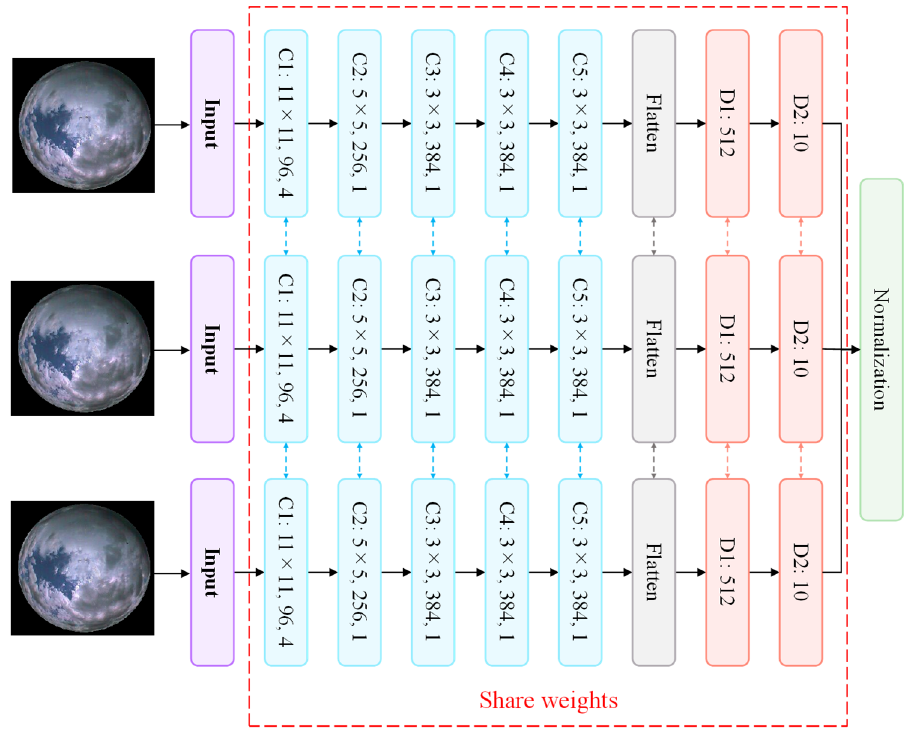
Figure 5. The structure of the siamese convolutional neural network with three subnetworks.